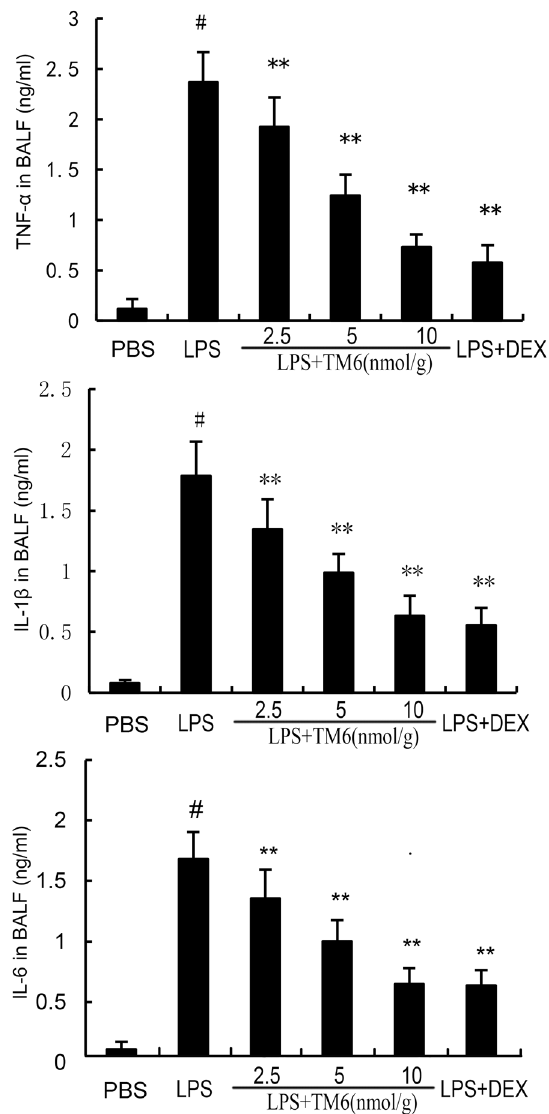
Figure 5. The effect of TM6 on MPO activity. MPO activity was determined 7 h after LPS administration. The values presented are the means ± SEM. (n = 6) # P < 0.01 is significantly different from the control group; * P < 0.05 and ** P < 0.01 are significantly different from the LPS